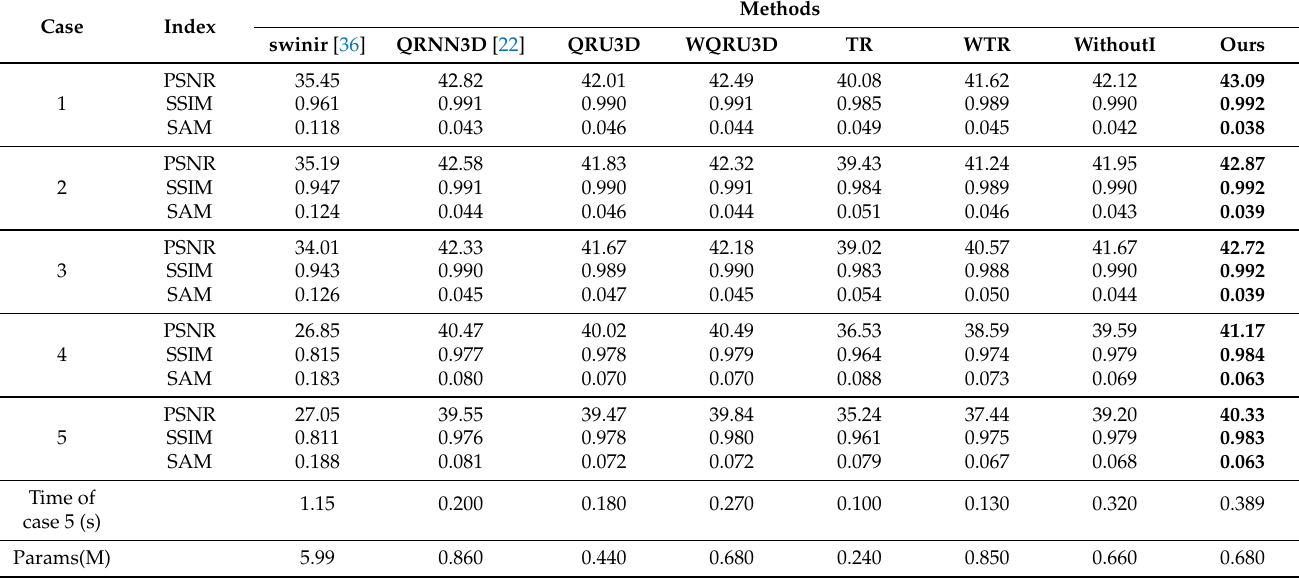
Table 7. Ablation study on ICVL dataset in five complex noise cases.